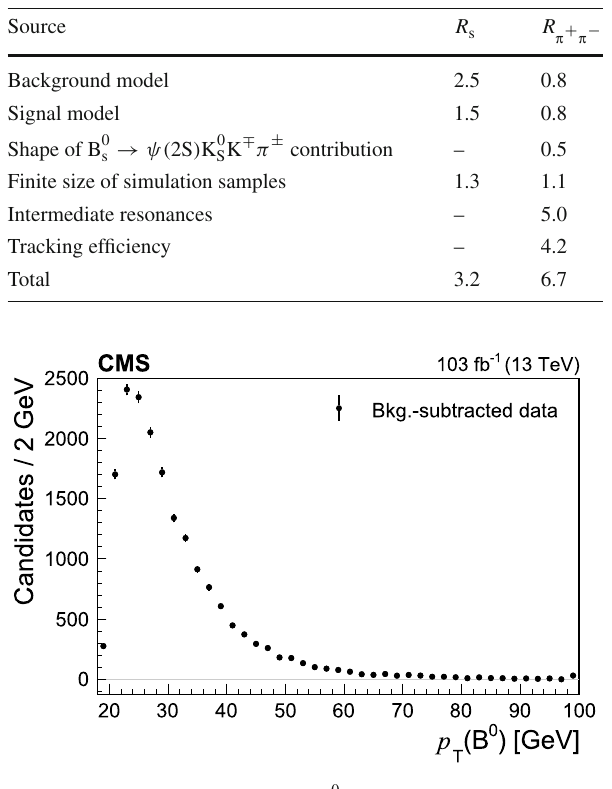
all cases the background shape parameters are free to vary in the